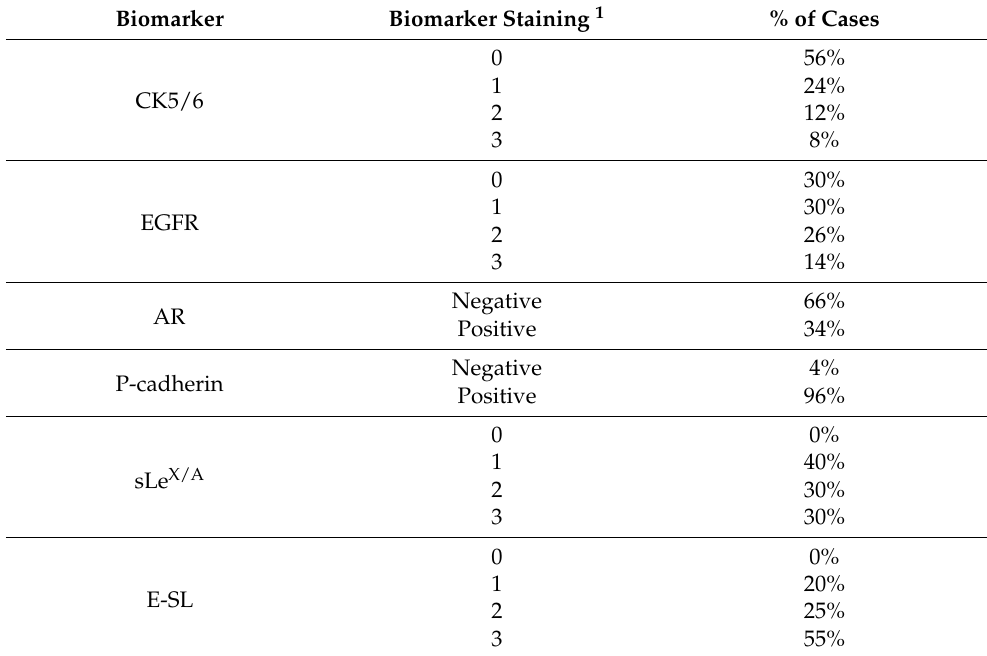
Table 1. Distribution of the expression of the biomarkers in the TNBC population tested in this study.